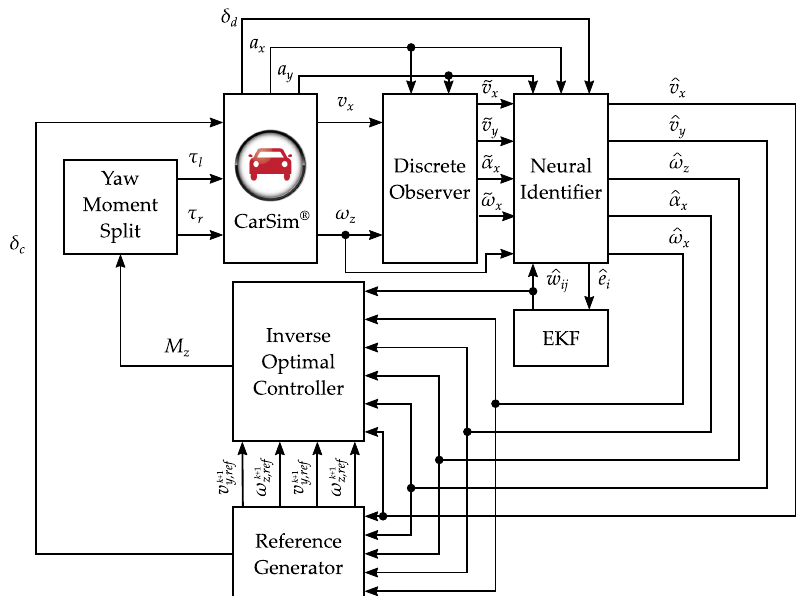
Figure 1. Control scheme for in–wheel electric vehicles safety stability